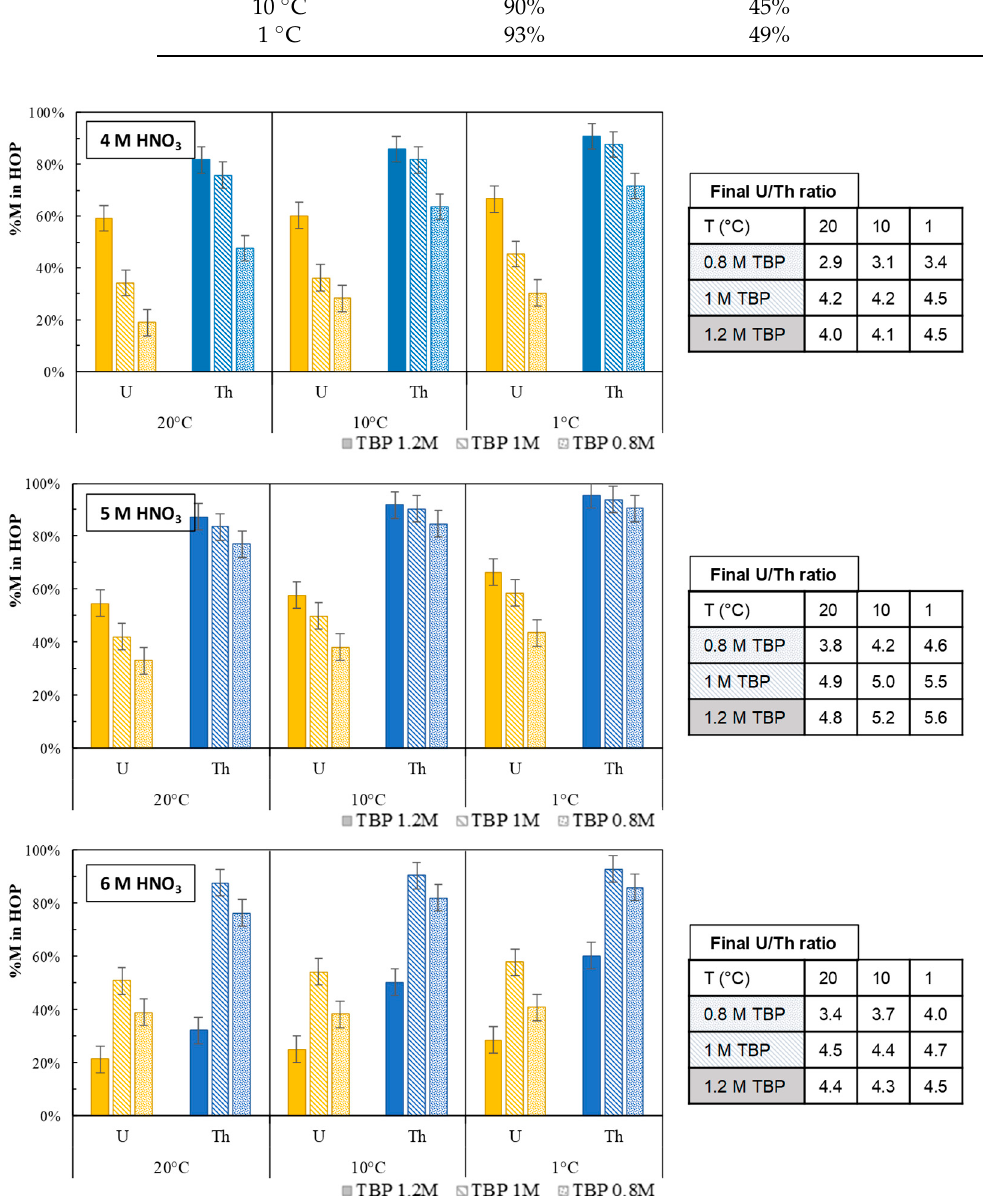
Figure 5. Distribution of U and Th in HOP and corresponding U/Th ratio after organic phase splitting, according to the aqueous HNO 3 concentration, the splitting temperature (T, °C), and the organic TBP concentration.